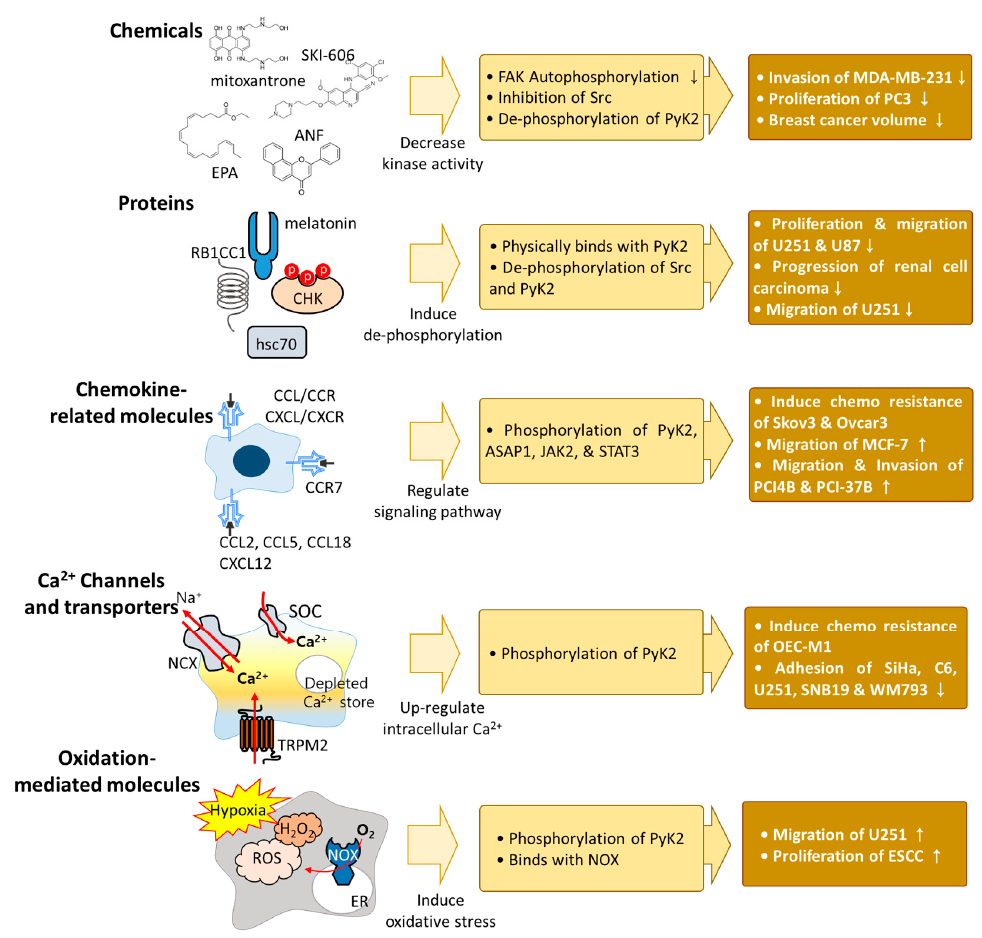
Figure 3. Schematic illustration of PyK2-associated molecules. Various molecules affect PyK2 activation, including chemical reagents, interactive proteins, chemokine-related molecules, Ca 2+ channels, transporters, and oxidation-mediated molecules. The phosphorylation of PyK2 induces cancer cell migration and proliferation. Various effector signals and chemicals exert different phosphorylation effects on PyK2. Thus, verification of the phosphorylation status of PyK2 could be a prognostic marker for evaluating cancer progression.